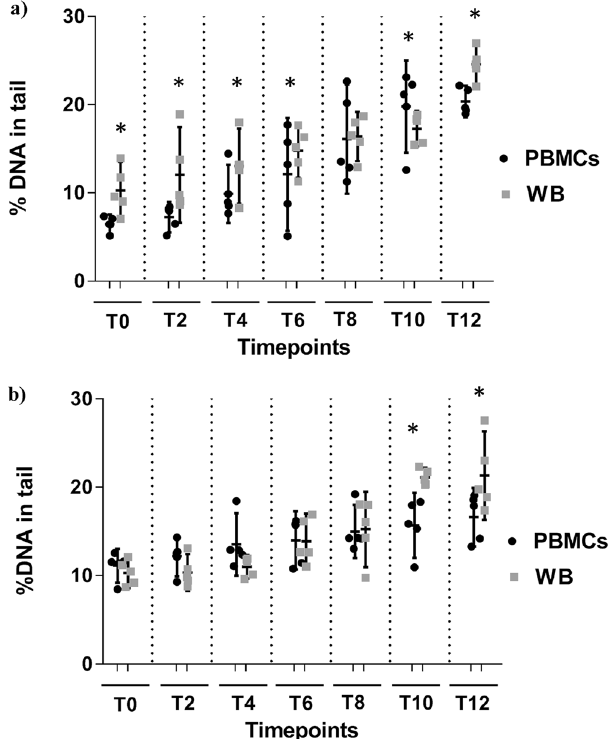
Figure 3. Comparison between PBMCs and WB for each of the replicates for ( a ) DNA SBs and ( b ) Fpg- sensitive sites. Results are displayed as percentage of DNA in tail along time (from time 0: fresh sample, till time 12 months of cryopreservation). * Significantly different ( p < 0.05) within each time points between PBMCs and WB